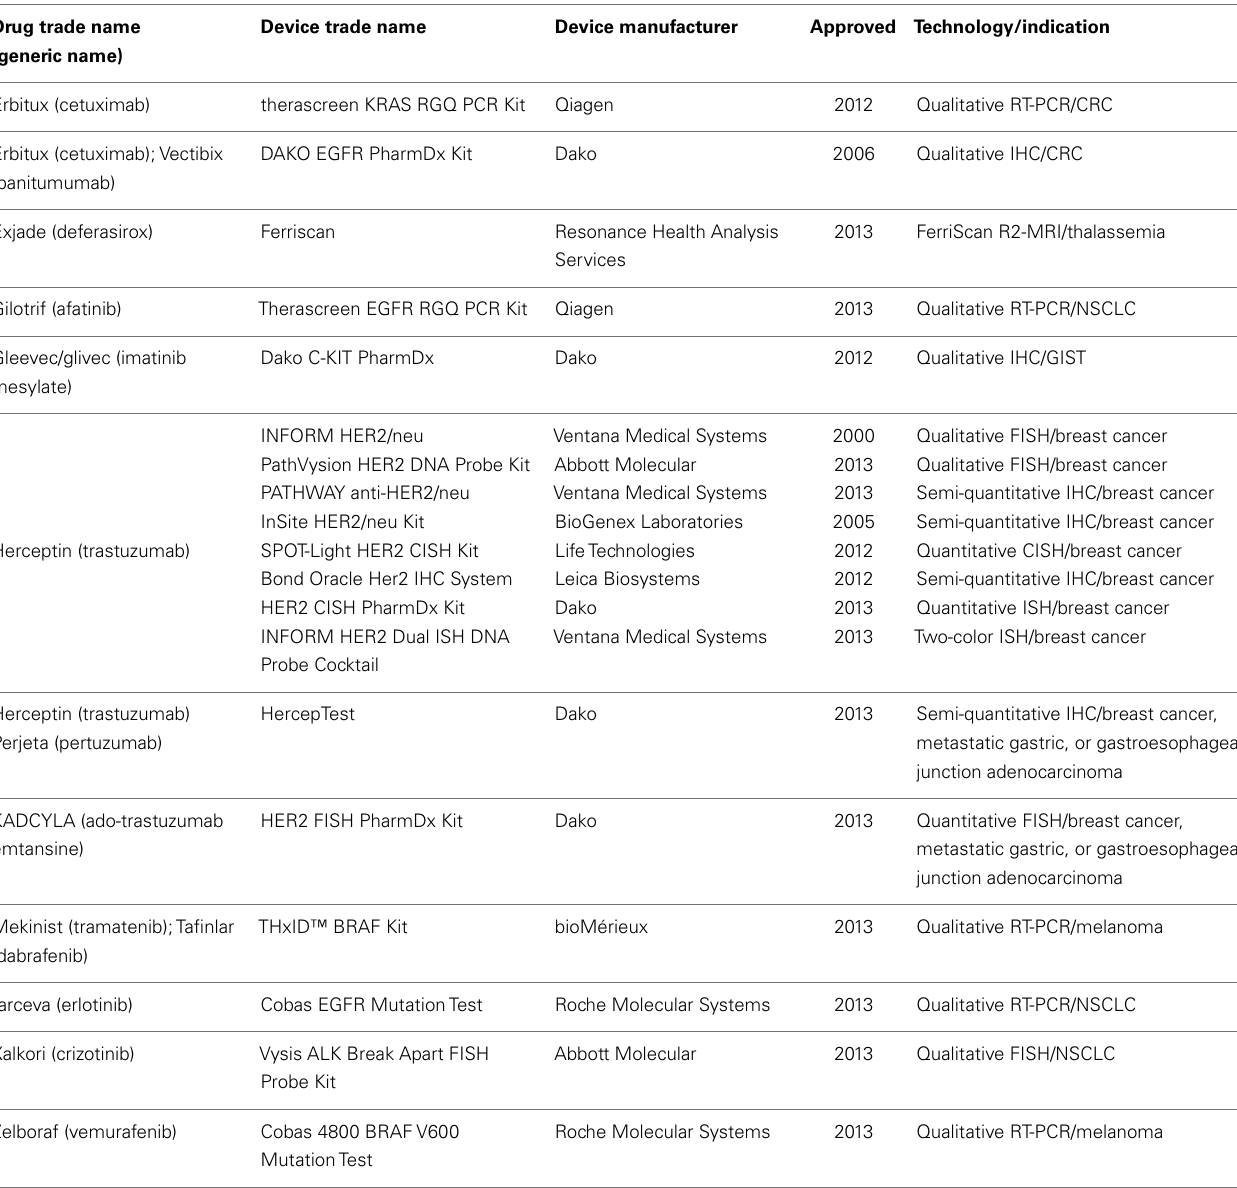
Table 1 | FDA approved companion diagnostics (CDx)